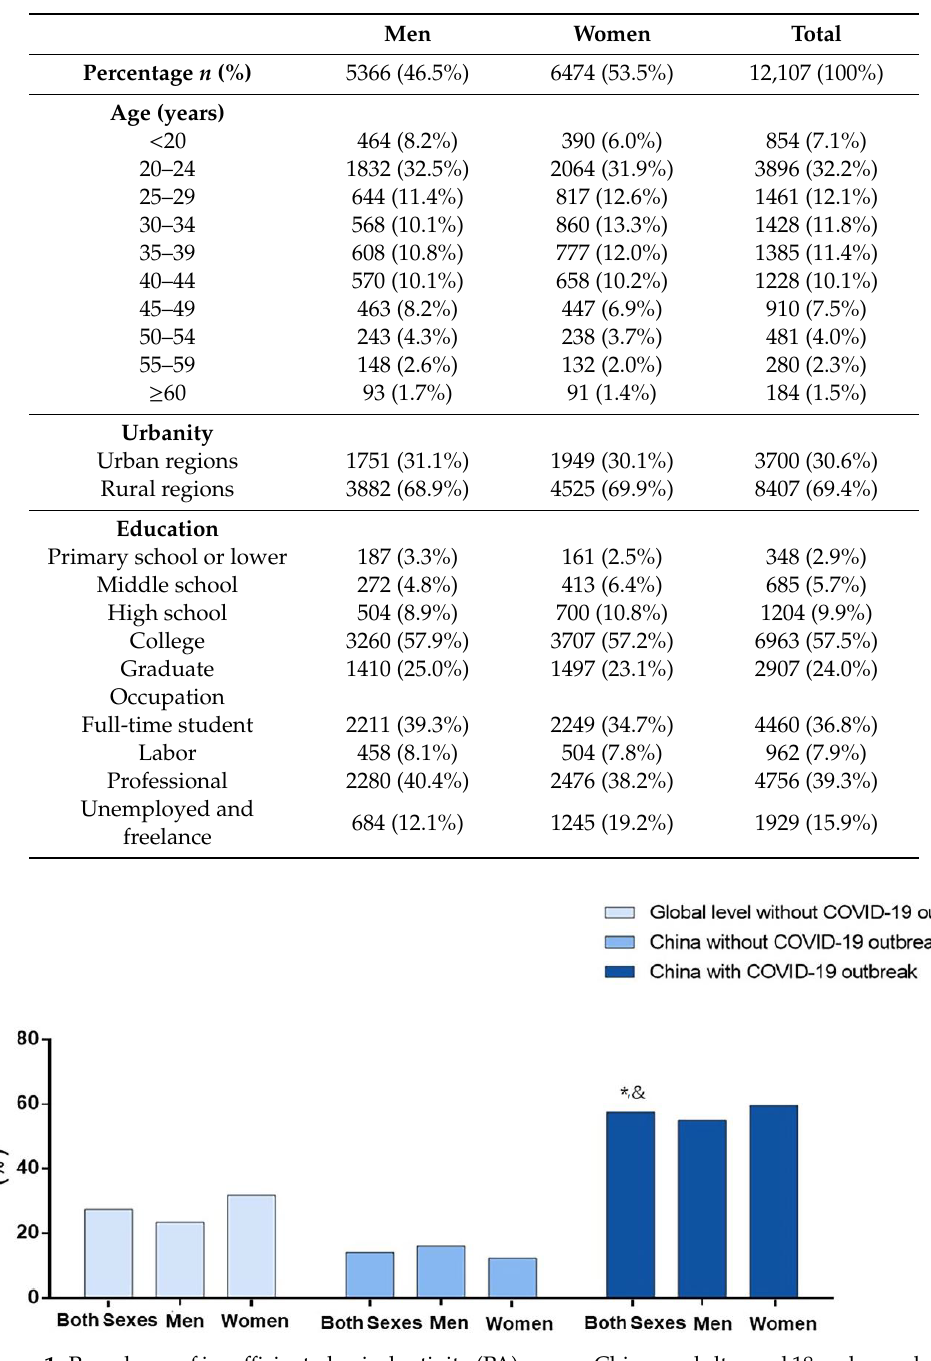
Table 1. Characteristics of the Chinese adults aged 18 and over during home quarantine induced by